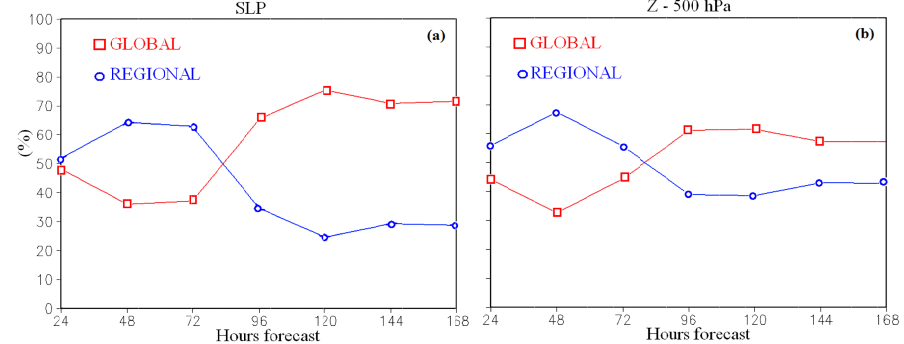
Figure 3. Evolution with time of the mean (over the whole domain) of the percentage of grid points in which the models had the smallest values of RMSE for winter and summer for (a) mean sea level pressure and (b) 500hPa